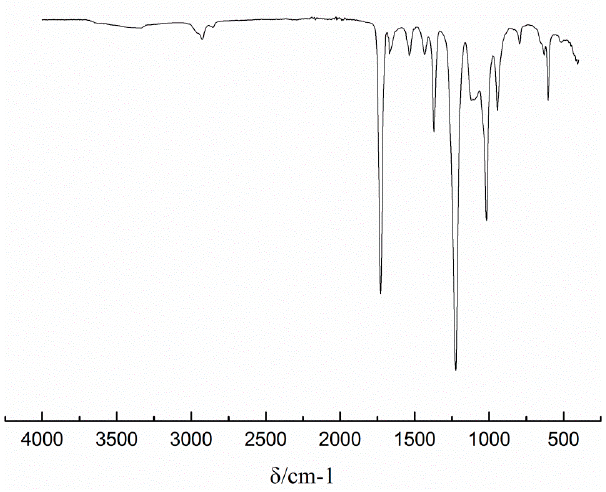
Figure 5. FT-IR spectrum of the latex film with 4% DNS-86.